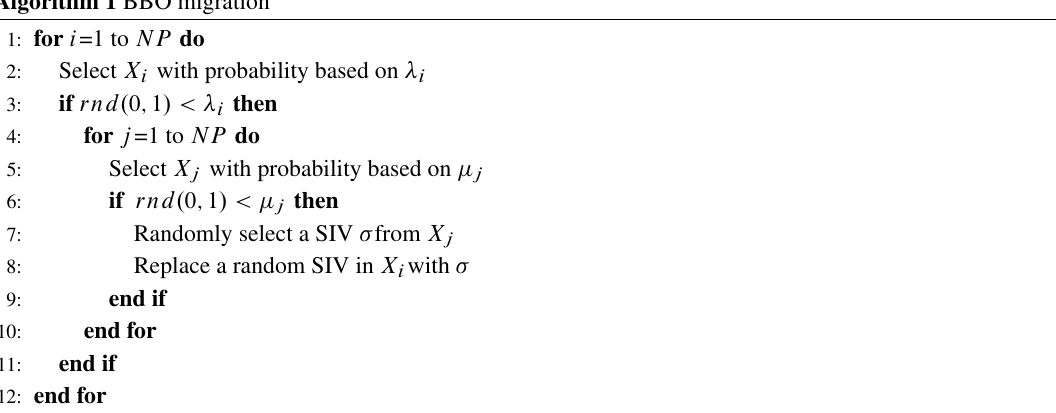
Algorithm 1 BBO migration